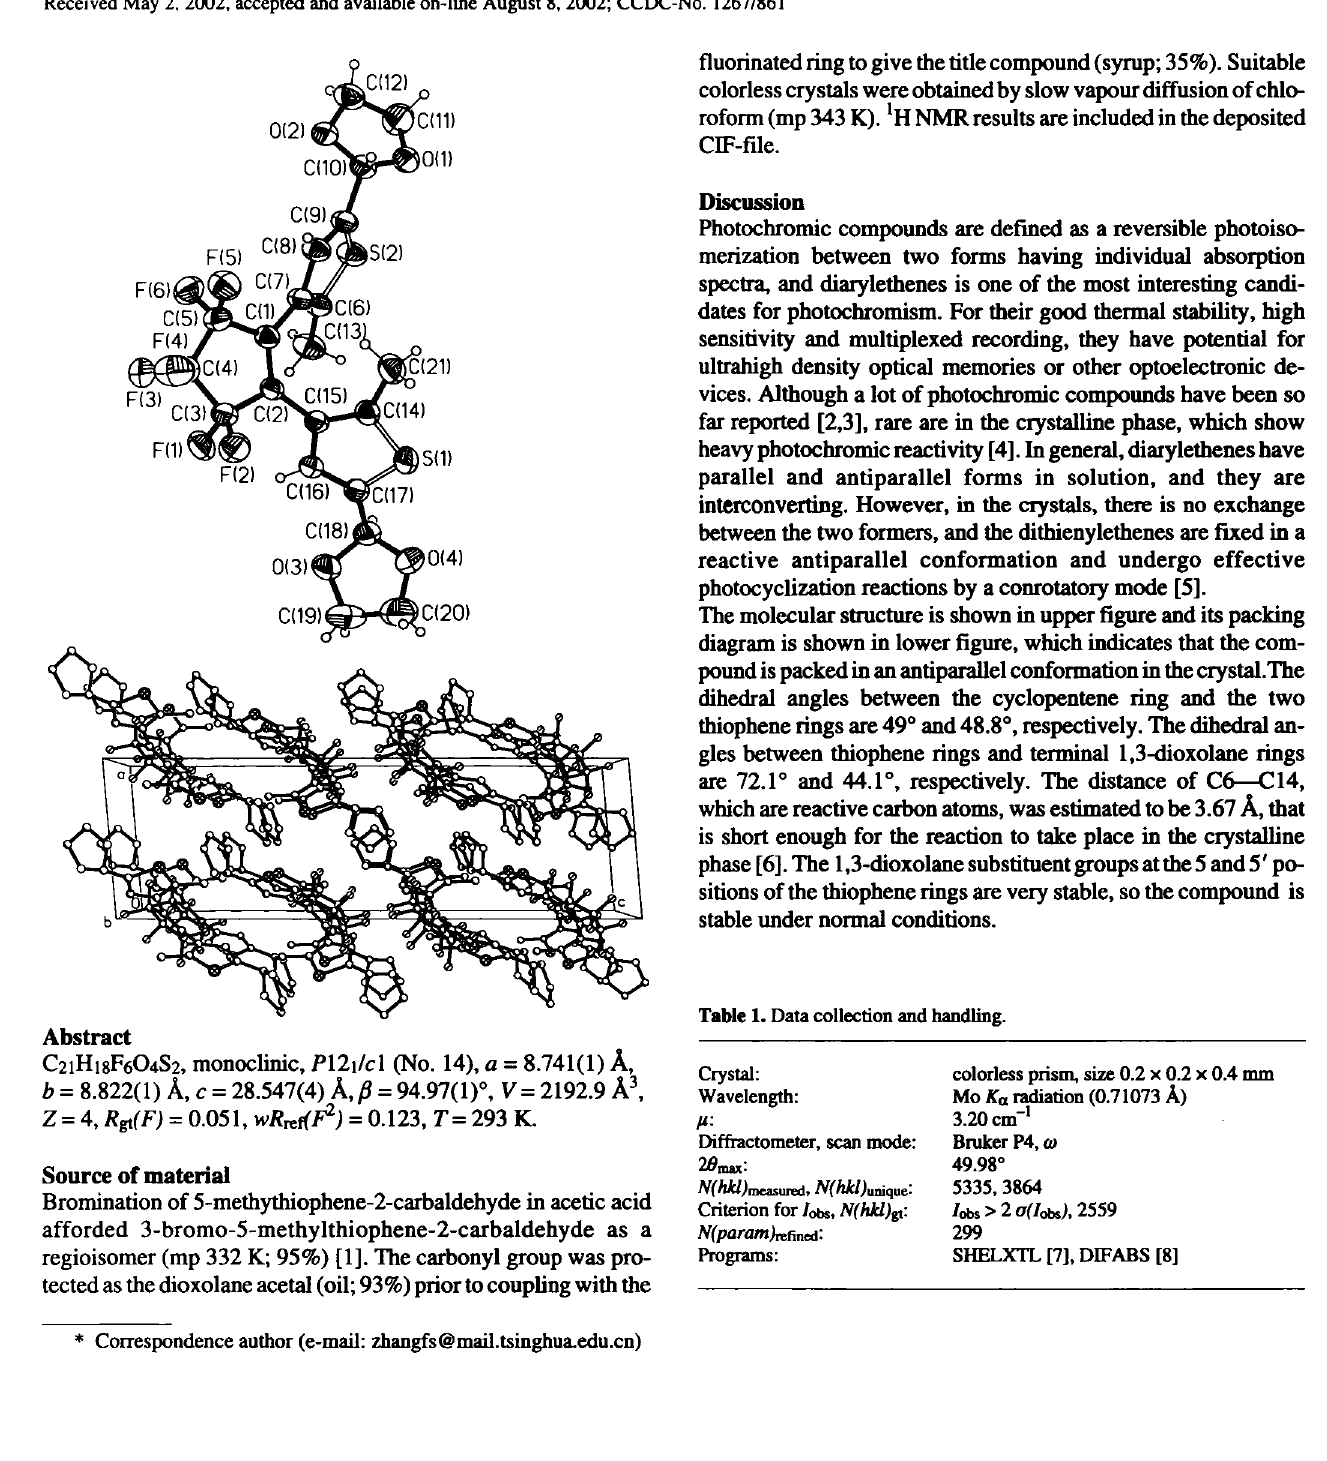
Table 1. Data collection and handling. Crystal: Wavelength: H- Diffractometer, scan